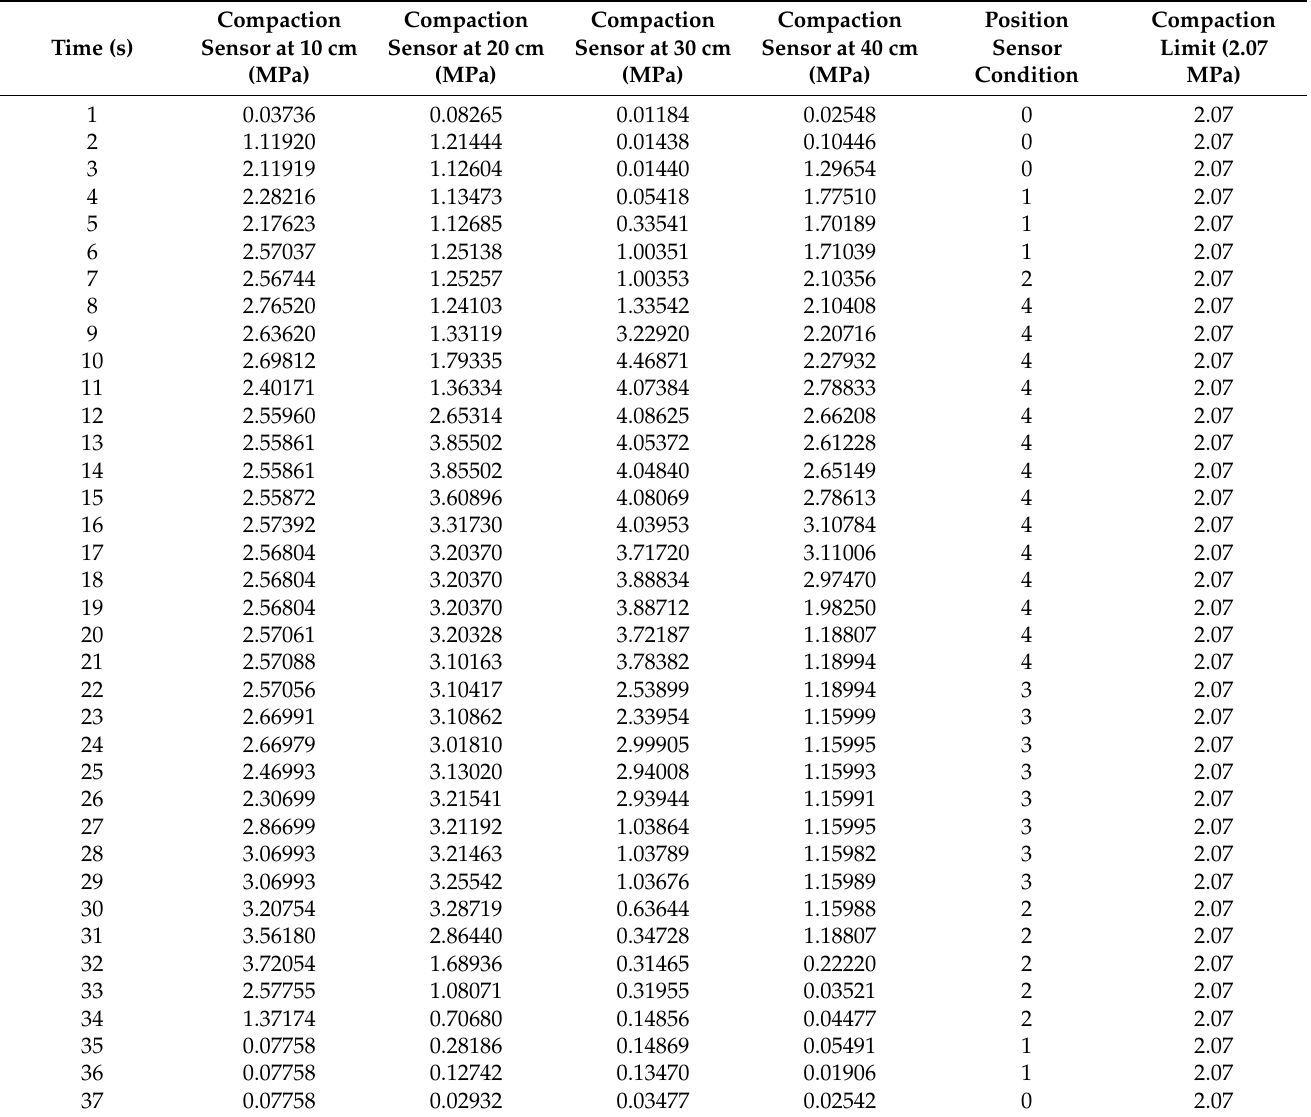
Table 2. Data received from the quadruple compression sensors and the feedback reaction of the five position